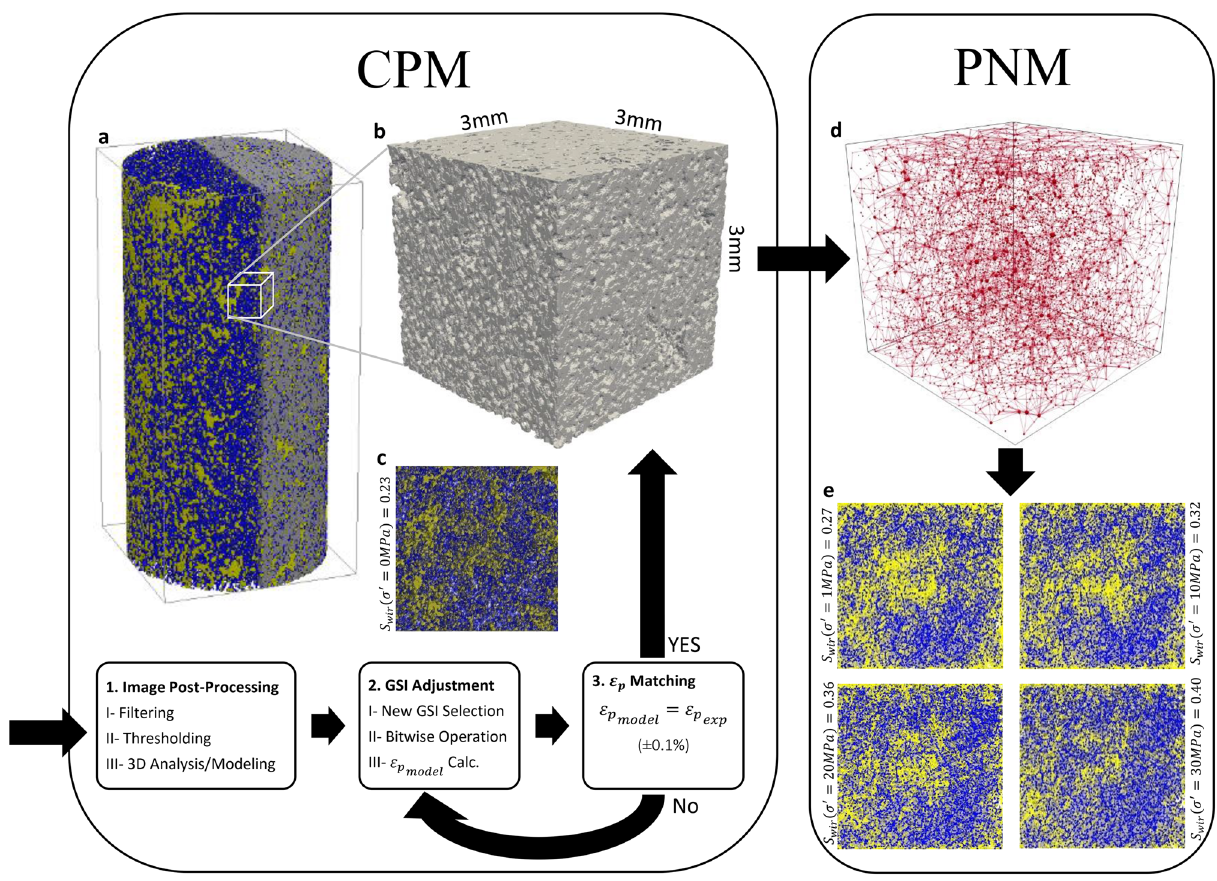
Figure 1. Workflow for stress-dependent pore flow modeling, σPFM. This figure shows ( a ) the 3D model of phase distribution in the unconfined core, ( b ) the cubic proxy model, ( c ) a 2D view of the phase distribution in the unconfined cube (blue is water and yellow is gas), ( d ) the stress-dependent extracted pore network model (PNM), and ( e ) 2D view of the simulated phase distribution in the cube (blue is water and yellow is gas) at S wir under increasing effective stress conditions. The conceptual proxy modeling (CPM) workflow consists of image post-processing, adjusting the grayscale index (GSI), and matching the proxy model’s pore strain ( ε pmodel ) with the experimental pore strain ( ε pexp ) at each effective stress